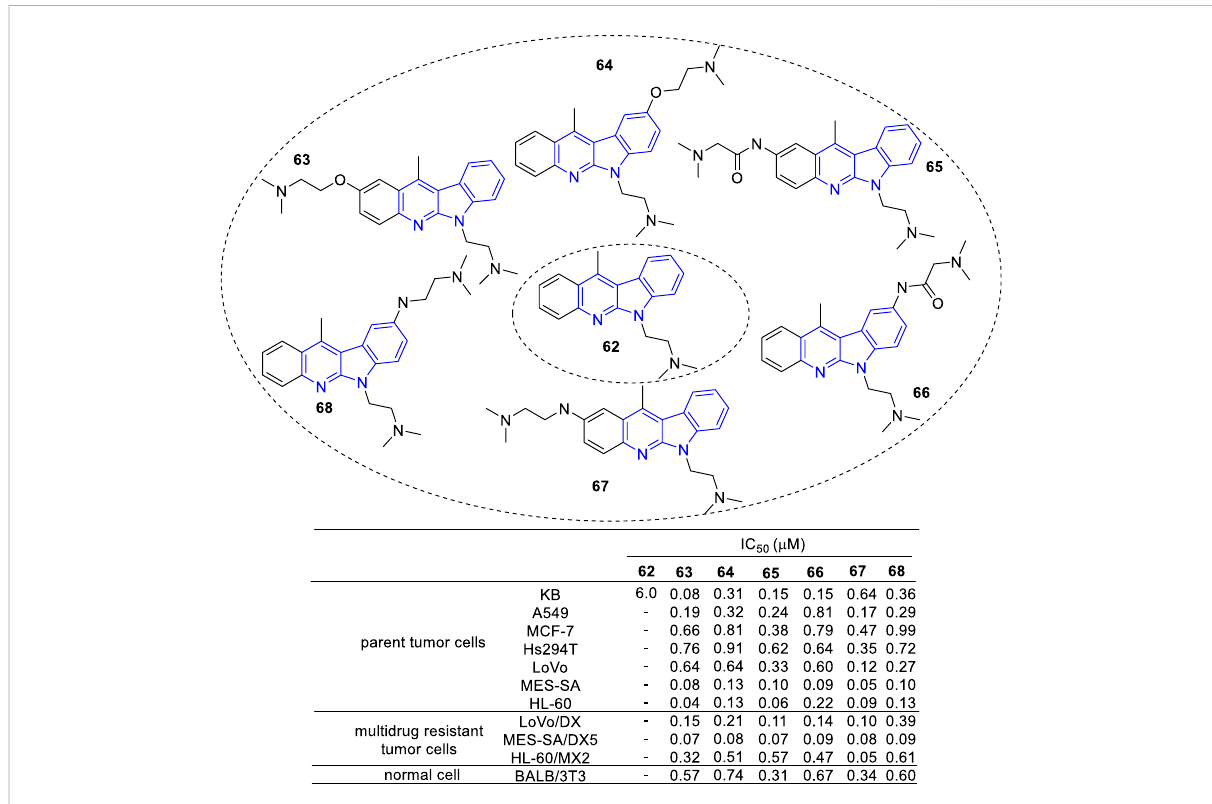
FIGURE 7 Structure and bioactivity of derivatives ( 62 – 68 ) which N-6 fi xed an (dimethylamino) ethyl chain, C-2 or C-9 linked another (dimethylamino) ethyl chain by amide, ether or amine